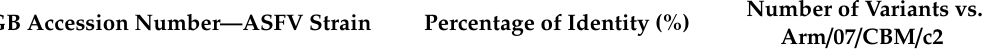
Table 6. Percentage of identity and number of variants found in Arm / 07 / CBM / c2 compared to other genotype II strains. Variants found in the strains indicated in bold are described in detail in Supplementary Table S3.